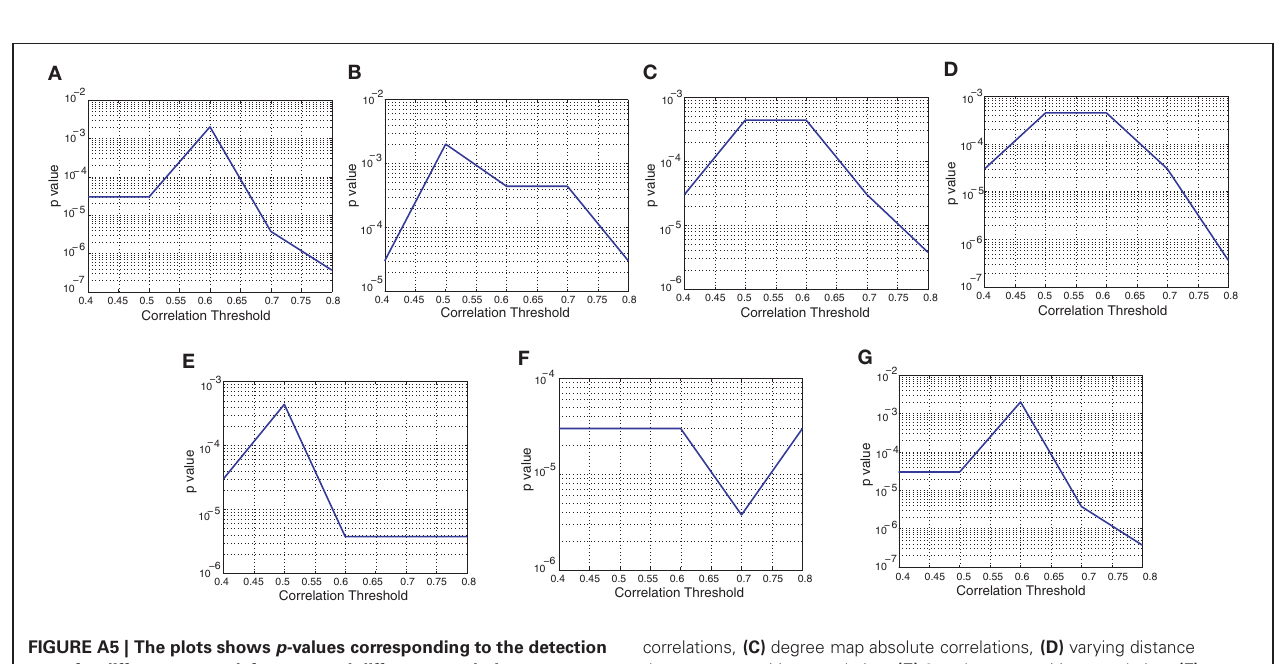
FIGURE A5 | The plots shows p -values corresponding to the detection rates for different network features and different correlation thresholds. (A) Degree map positive correlations, (B) degree map negative